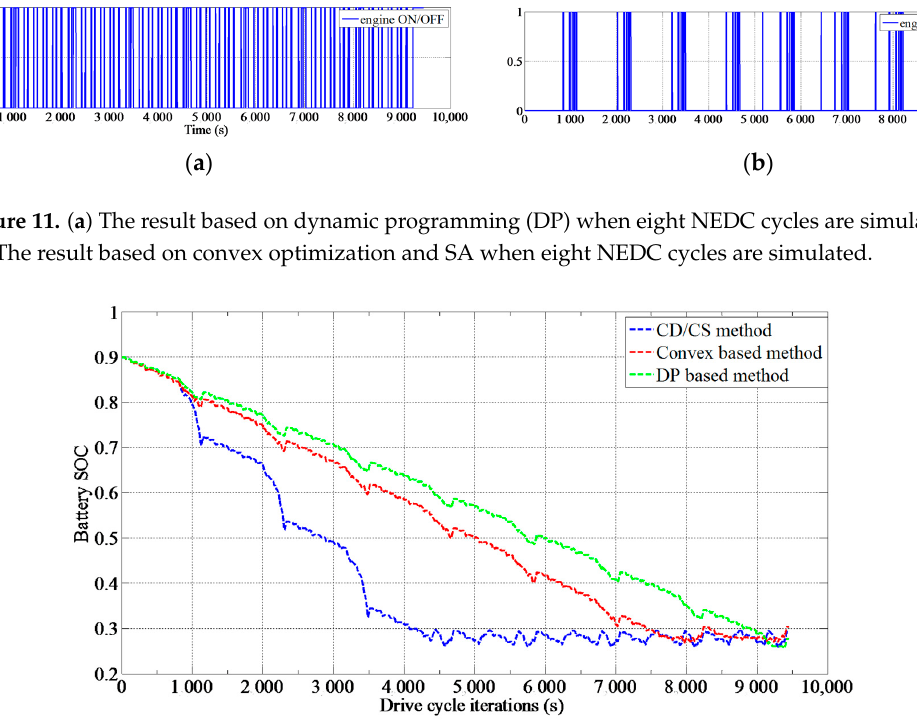
Figure 12. Battery SOC comparison.